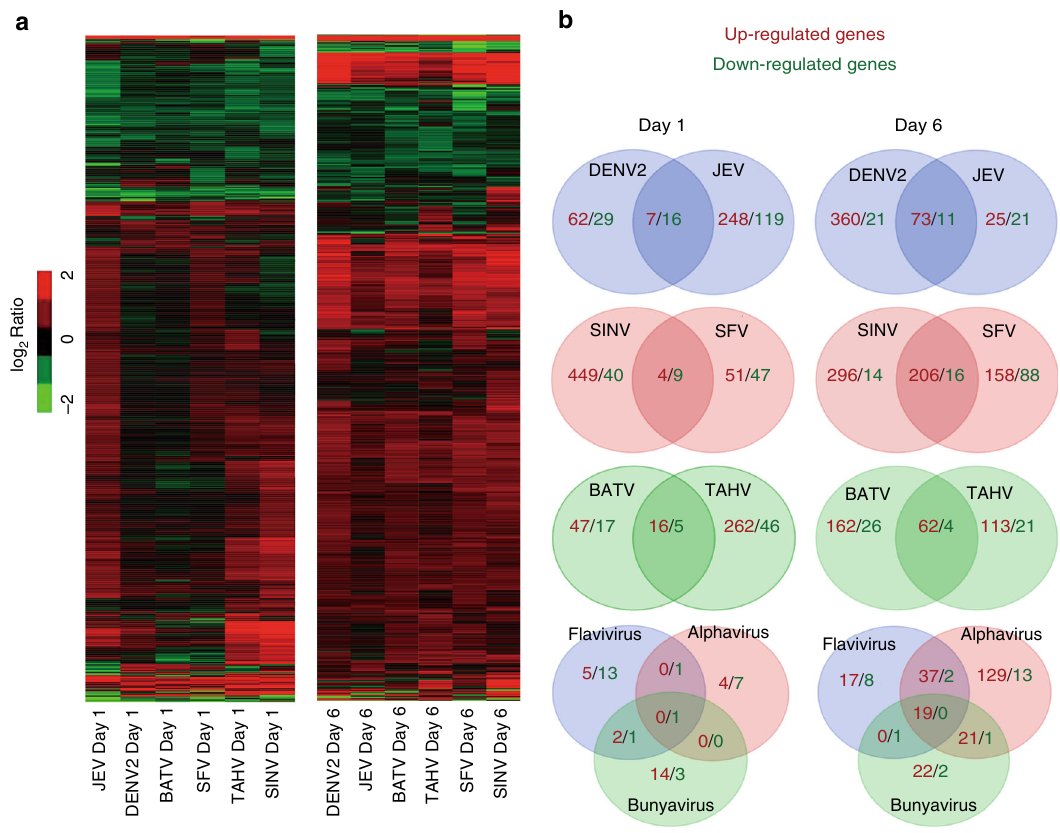
Fig. 1 Genes regulated by Flavivirus , Alphavirus a Orthobunyavirus infections in A. aegypti . a Genes regulated by infections with various viruses in A. aegypti . For RNA-Seq analysis, total RNA was extracted with TRIzol from the mosquitoes infected with 100 M.I.D. 50 of viruses on 1 and 6 days post-viral inoculation. The log 2 ratio (read number in the virus-induced whole mosquito/read number in the control whole mosquito) was exploited to evaluate gene regulation. Genes with a log 2 ratio ≤ − 1.5 or ≥ 1.5 were selected for further analysis. b Venn diagram schematic representation of up-regulated or down- regulated genes by virus